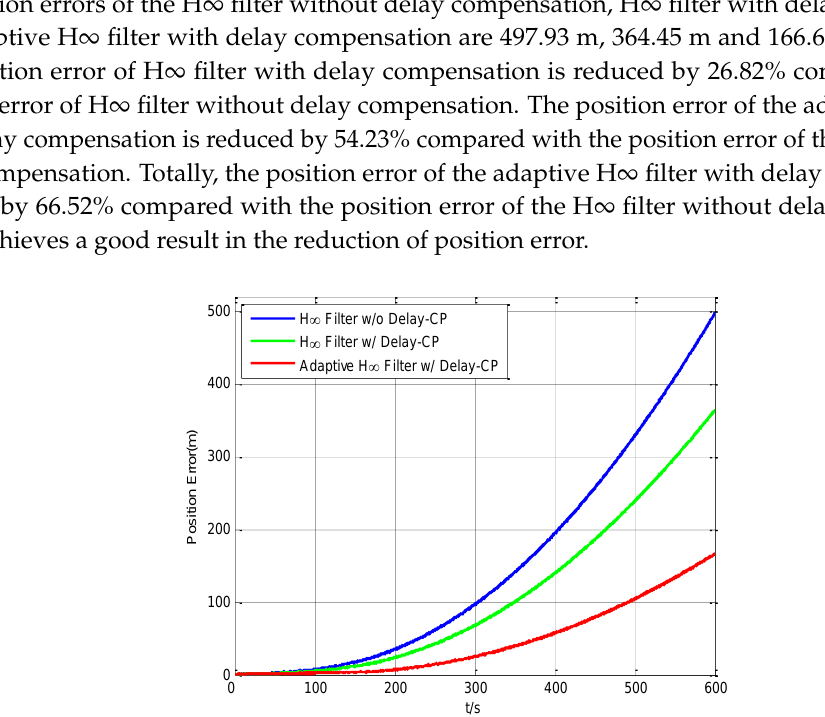
Figure 14. The curves of position error in inertial navigation.